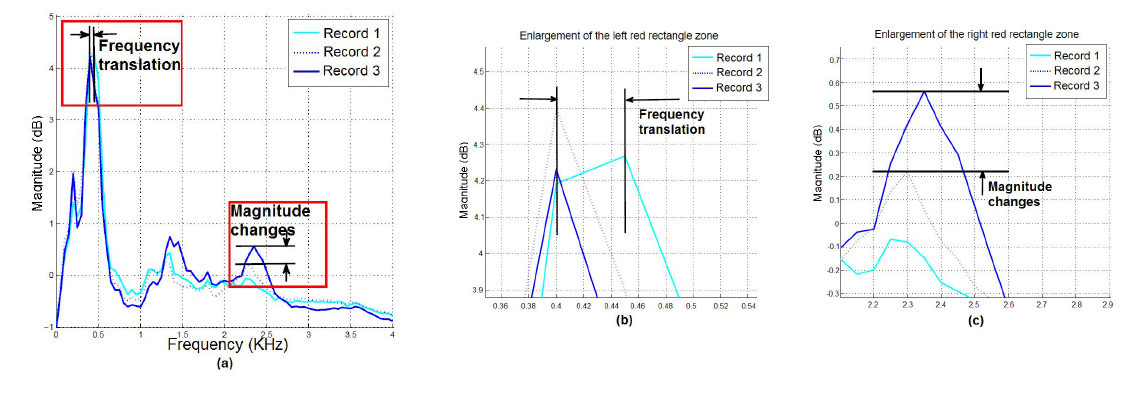
Figure 3. Spectral magnitude representation. ( a ) The entire spectra for the three records; ( b ) illustration of how frequency can change from one record to another for the same speaker; ( c ) illustration of how magnitude can change from one record to another for the same